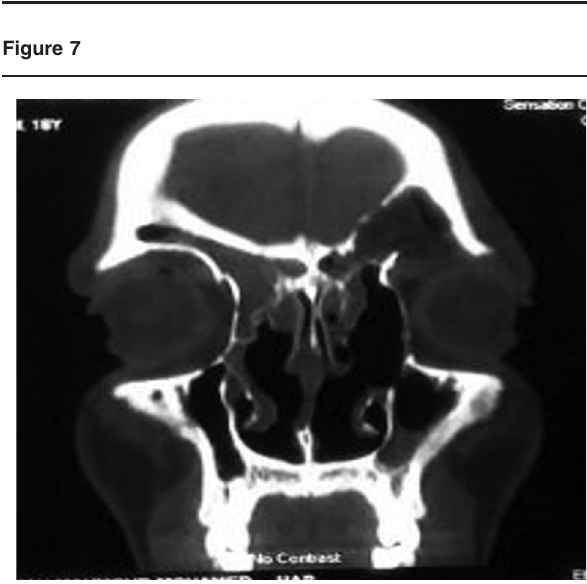
CT PNS coronal cut showing clearance of allergic fungal sinusitis, far lateral mucocele and successful obliteration (yellow arrow).